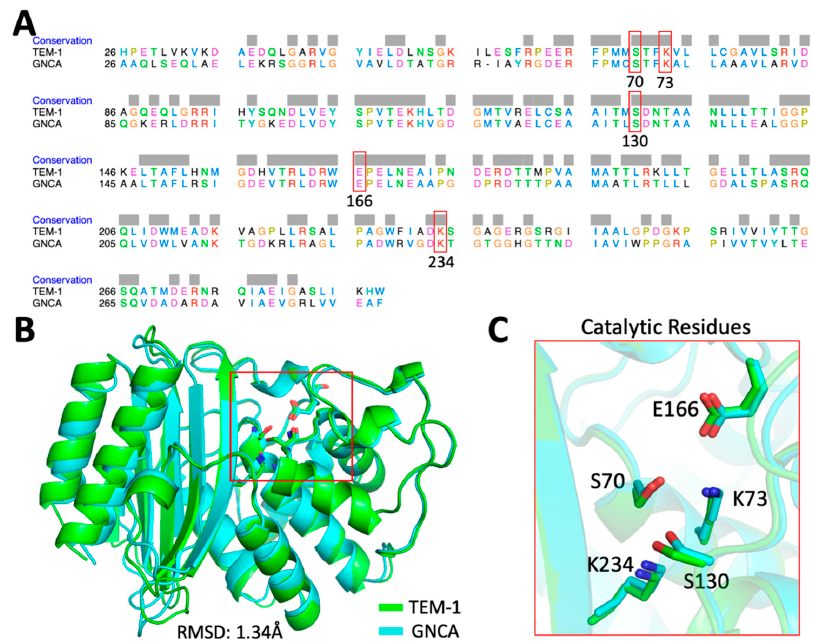
Figure 1. Differences in sequence and structure between TEM-1 and its ancestral variant GNCA. ( A ) Sequence alignment (Ambler numbering) [31] of TEM-1 and GNCA shows a 54% sequence identity; conserved active site residues are highlighted in red boxes. ( B ) The crystal structures of TEM-1 (PDB ID: 1btl, green [32]) and GNCA (PDB ID: 4b88, cyan [33]) are superimposed and the catalytic residues are shown as sticks within a red box. The low root-mean-square deviation (RMSD) indicates a high conservation of structure. ( C ) Active site residues in TEM-1 and GNCA are shown in green and blue sticks,